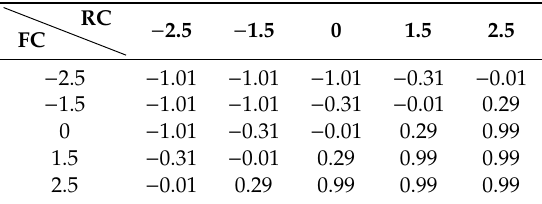
Table 6. Rules for fuzzy—Rule 4.